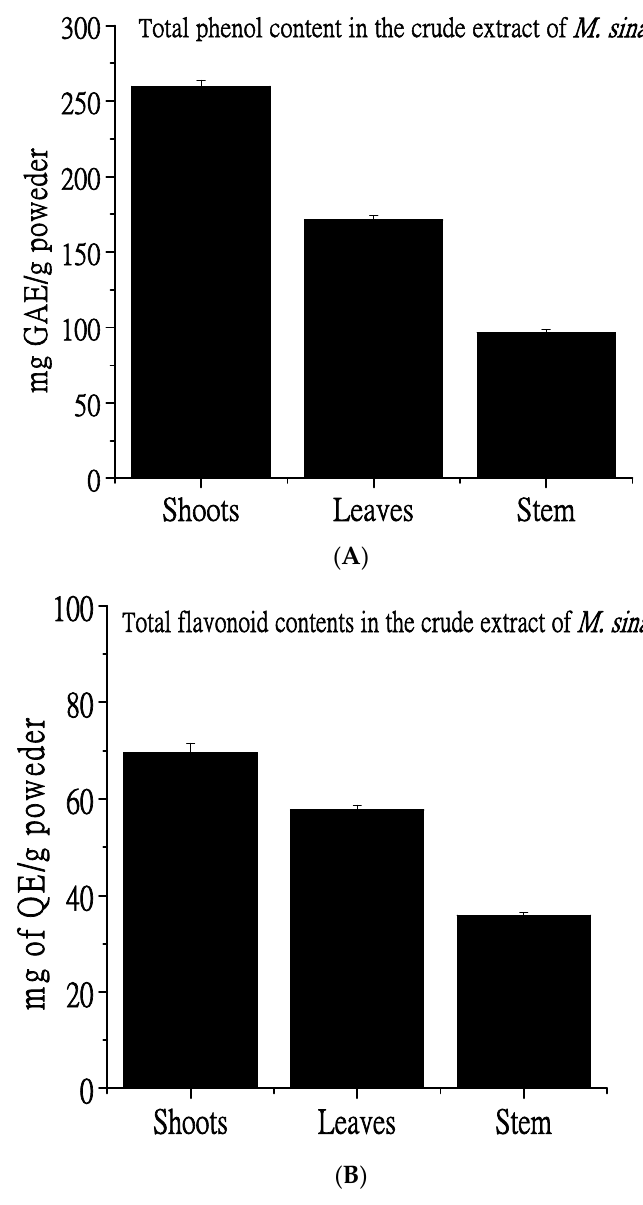
Figure 1. Total phenol and flavonoid content. ( A ). The shoots exhibited the highest phenol and flavonoid contents, and the total phenolic contents of shoots, leaves, and stem extracts were 259.7 ± 0.57, 171.2 ± 1.68, and 96.5 ± 2.98 mg gallic acid equivalents (GAE)/gm. ( B ) Total flavonoid contents of shoots, leaves, and stem extract were 69.5 ± 1.07, 57.7 ± 0.57, and 35.9 ± 2.57 mg quercetin equivalent /g of the extract.